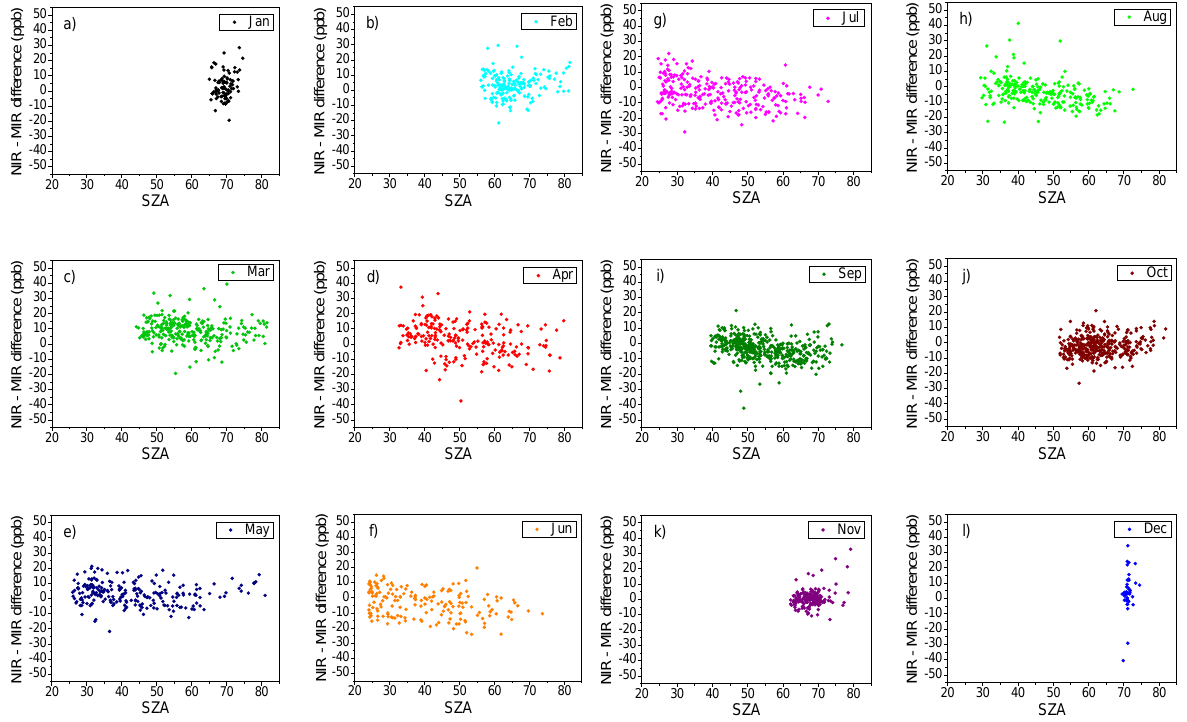
Fig. C4. Monthly mean NIR–MIR differences (10-min coincidences) for Garmisch retrievals with common ACTM a priori profiles as a Fig. C4. Monthly-mean NIR-MIR differences (10-min coincidences) for Garmisch retrievals function of solar zenith angle (SZA). with common ACTM a priori profiles as a function of solar zenith angle (SZA).